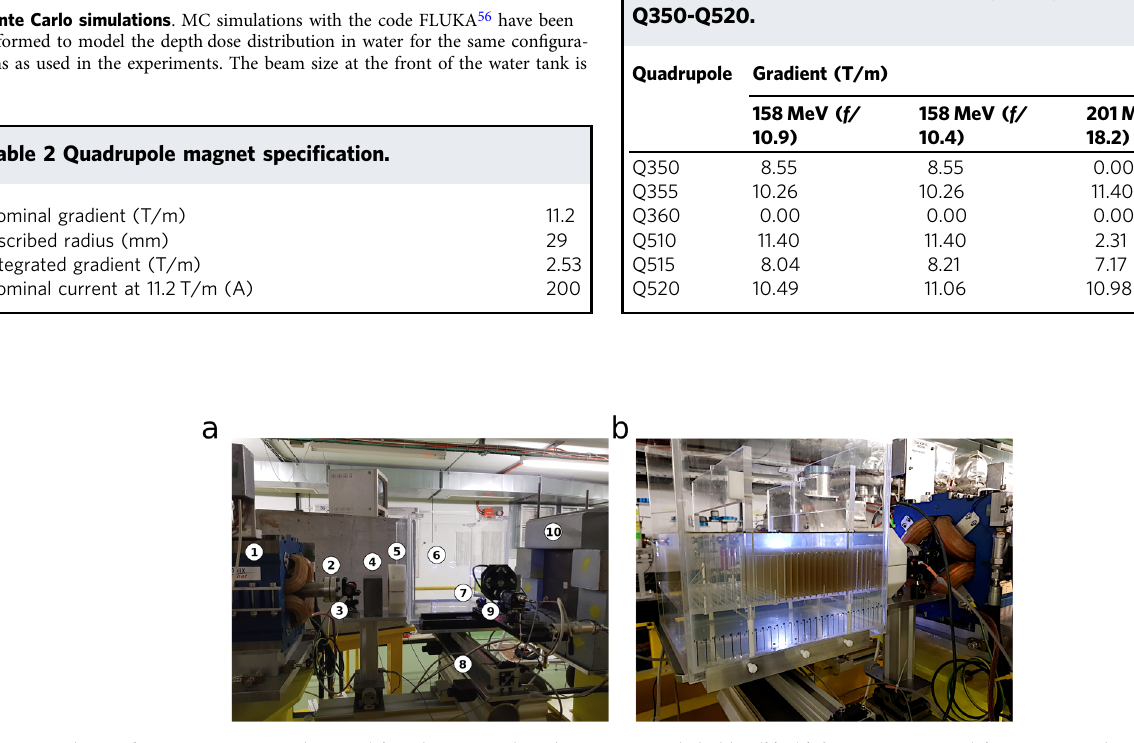
Table 4 Optimised gradients of the quadrupole magnets